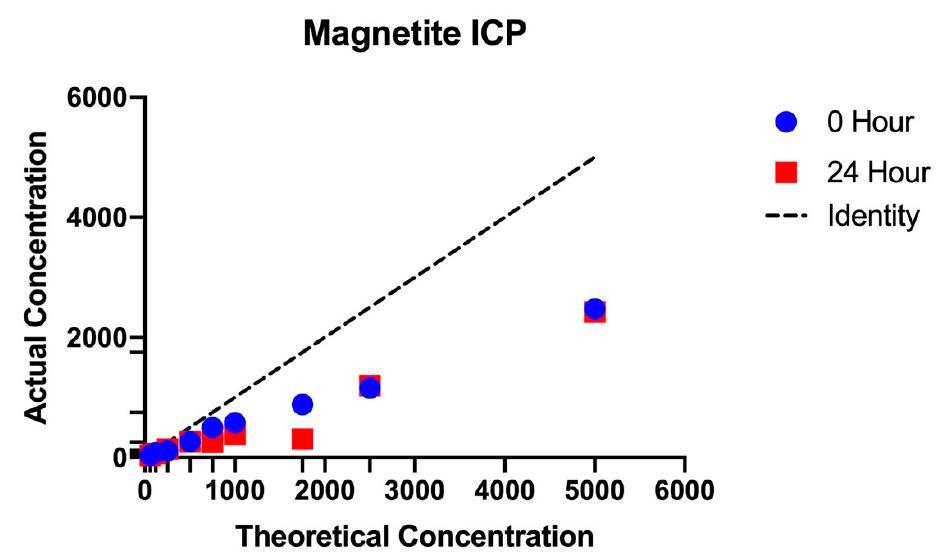
Figure A3. The amount of magnetite at 0 and 24 h resulting from magnetite in DMB medium.